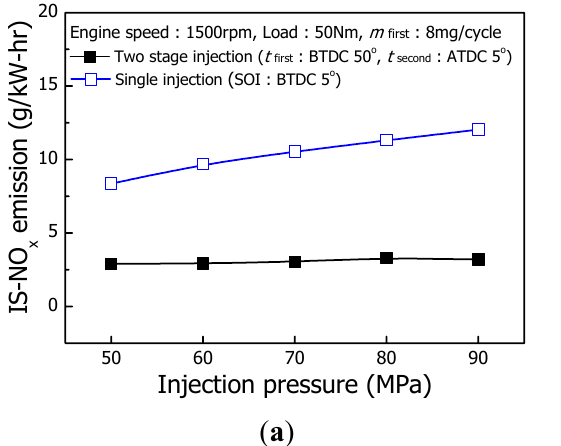
Figure 8. IS-NO and IS-Soot emission characteristics according to injection pressure of x two stage injection: ( a ) IS-NO ; ( b ) x